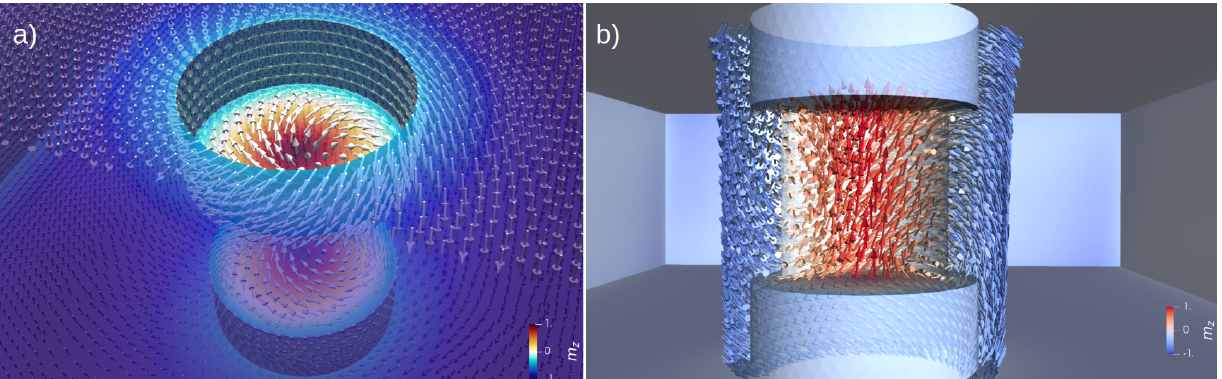
Figure 4. ( a ) A skyrmion is formed at the base of the cylindrical pocket. At the inner cylinder surface of the cavities, the magnetization circulates on closed loops, thereby facilitating the formation of the skyrmion in the center. The semitrans- parent representation of the surfaces shows the formation of the skyrmion in both pockets, on the top and bottom surfaces. The magnetic structure is displayed by arrows on the sample surfaces. Some of the arrows have been removed in order to improve the visibility of the structure. ( b ) View on the simulated skyrmion structure from inside the film. The skyrmion core connects the bases of the cylindrical pockets in the positive z direction, while the surrounding volume is magnetized in the negative z direction. The core of the skyrmion is delimited by a cylindrical isosurface m z = 0, shown here as a weak, transparent contrast in order to preserve the view on the central magnetic structure. Only a small subset of the calculated local magnetization vectors is